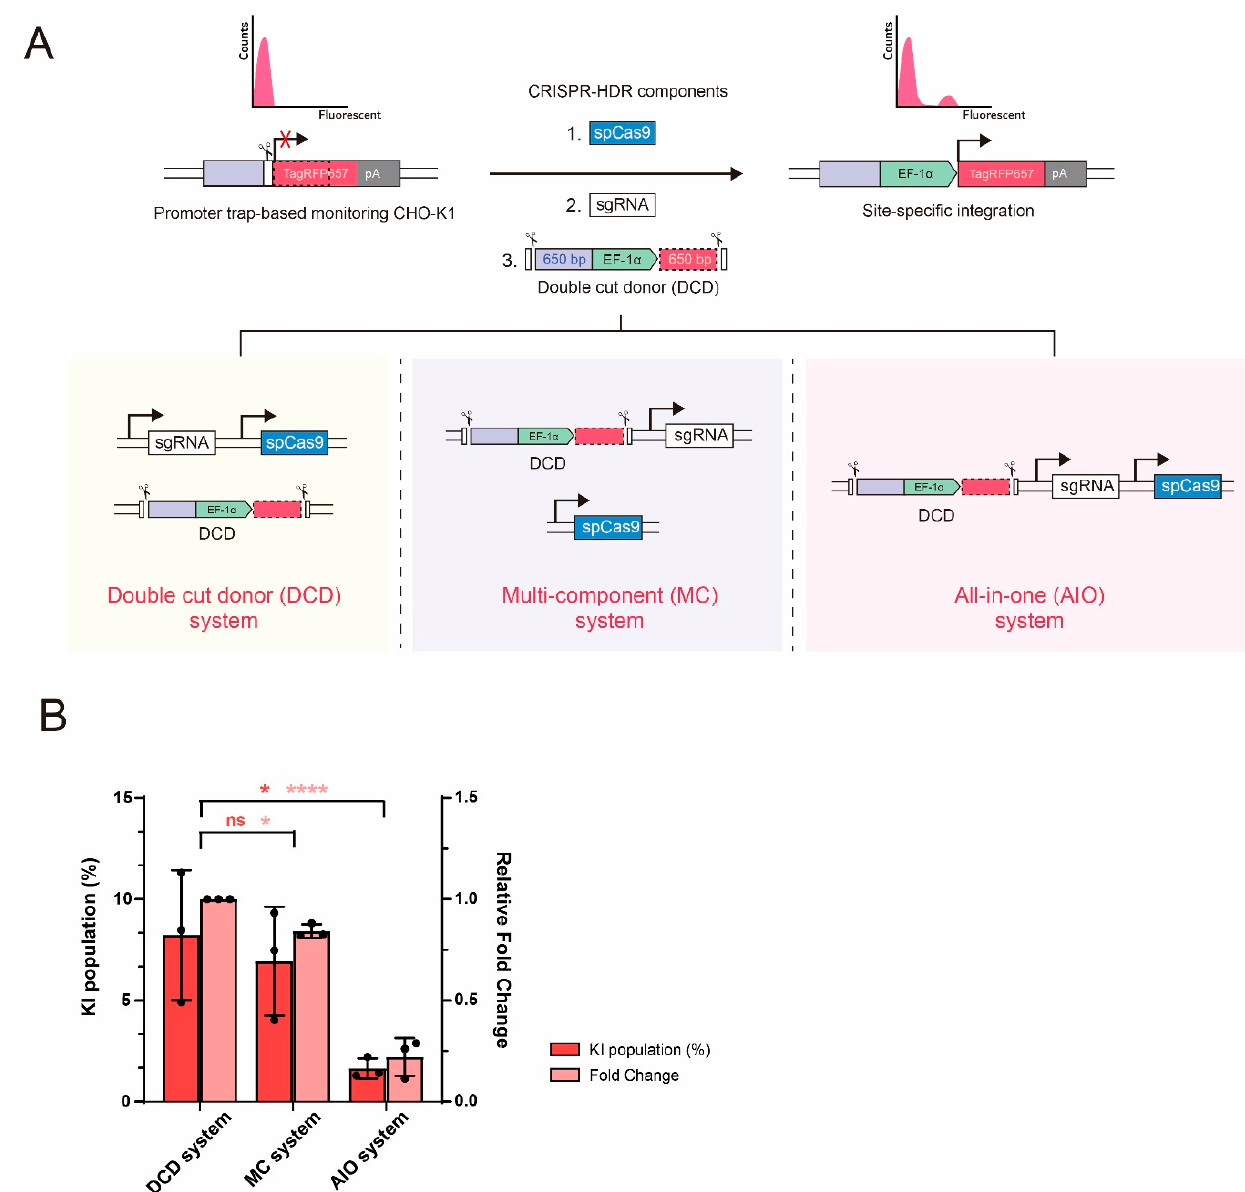
Figure 1. Different vector configurations for CRISPR/Cas9-mediated site-specific integration in CHO cells. ( A ) Schematic illustration of promoter trap-based TI monitoring CHO-K1 cell line and three different systems (DCD, MC , and AIO). Introduction of Cas9, sgRNA, and double cut donor (DCD) template into monitoring cell line leads to homology-mediated targeted integration of human EF-1 α promoter and restoration of TagRFP657 expression. ( B ) Flow cytometry analysis of DCD, MC , and AIO systems 6 days after transfection. The vector constructs were transfected at equal amounts (5:5, w/w) in the DCD and MC system. Absolute (%) and relative fold changes in TagRFP657 + cells were analyzed following the statistical analysis described in the materials and methods section. Relative fold change is normalized to the value obtained with the DCD system. The error bars represent the mean ± standard deviation from three independent experiments. * p ≤ 0.05, **** p ≤ 0.0001; ns, not significant.